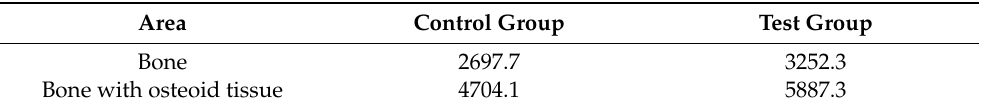
Table 4. Histomorphometric